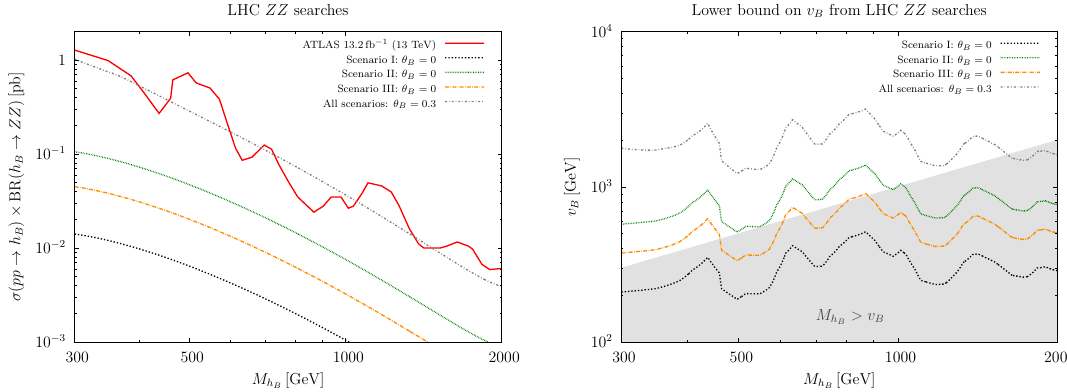
Figure 6 . Constraints from ZZ searches [30]. Left panel: experimental bounds as well as cross section predictions in scenarios I, II, and II as a function of the baryonic Higgs mass. Cross sections are shown both for negligible mixing angle and for a near maximal value of (cid:18) B = 0 : 3 for which the three scenarios coincide. Right panel: experimental bounds translated into lower limits on v B as a function of M h . In the left panel we use v B = 2 TeV, and in both panels n f = 3 and m Q = 1 TeV. B